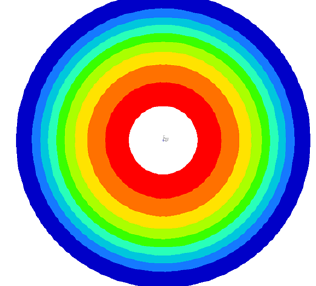
Fig. 4 Surface deformation of the reflector under loads.